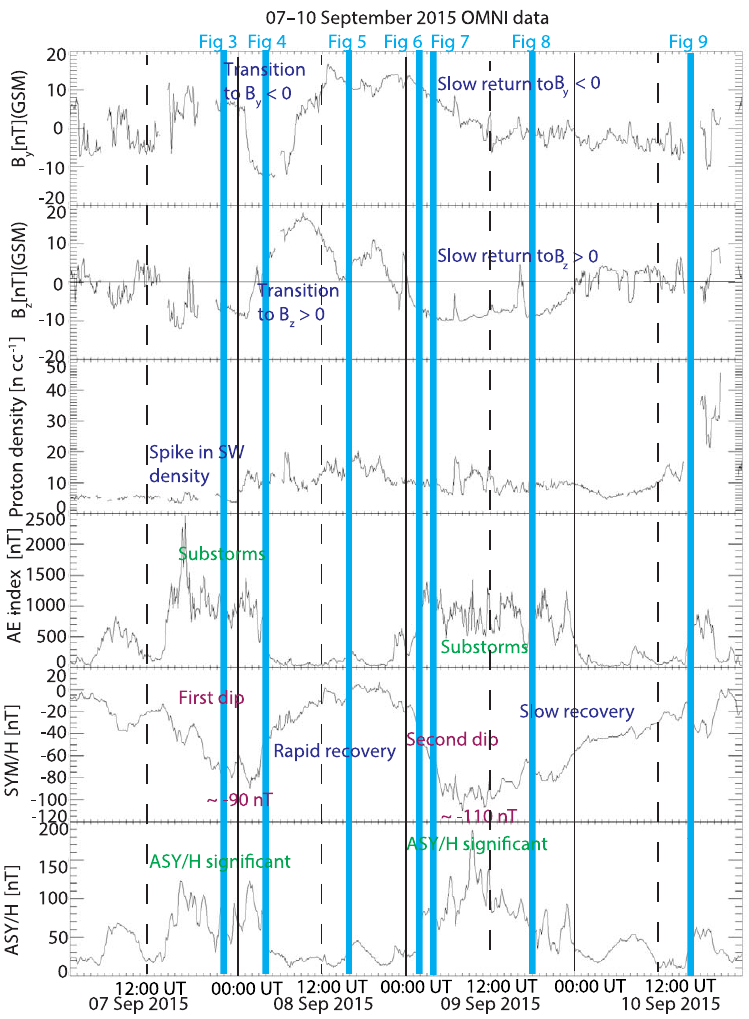
Figure 1. The solar wind parameters and geomagnetic indices for the two storms during the period 7–10 September 2015. The data are from the OMNI database (https://omniweb.gsfc.nasa.gov/html/omni_min_data.html, last access: 14 October